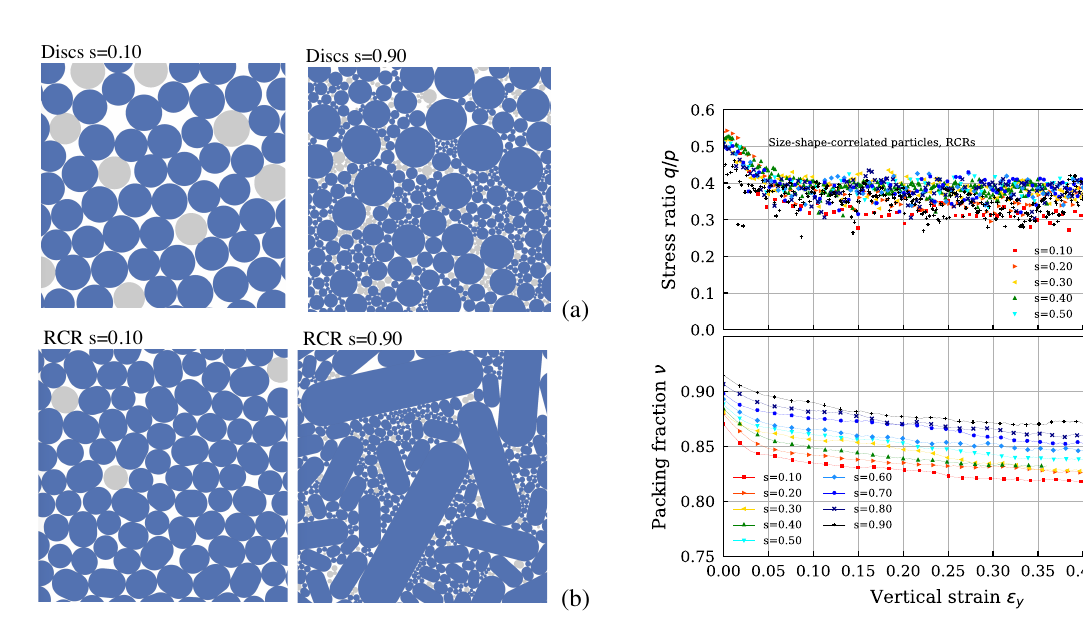
Figure 3. Evolution of shear stress ratio q / p and packing frac- tion ⌫ as functions of the vertical strain " y , for the series com- posed of particles with size and shape correlated (RCRs). Colors represent di ↵ erent values of the sample size-span s , which vary between s = 0.1 (close to uniform) and s = 0.9 (very well graded or